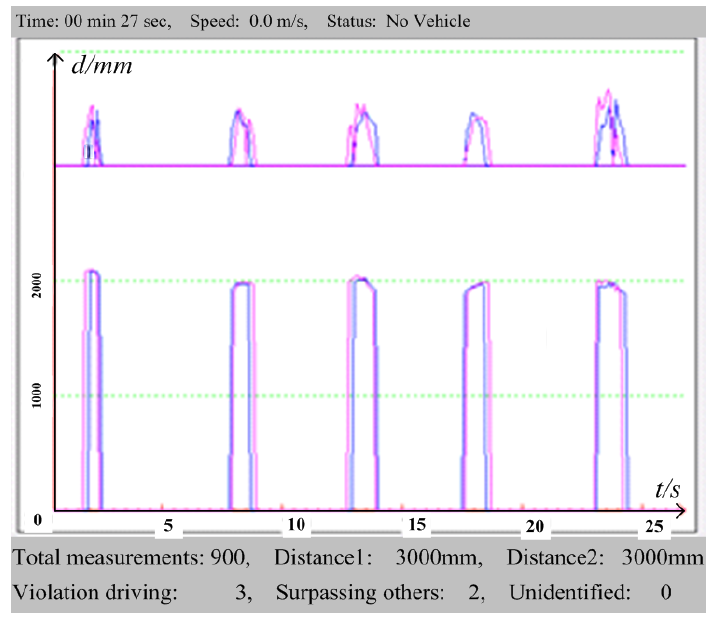
Figure 17. Reflection signal strength and real-time distance measured by the sensors and displayed on PC software.